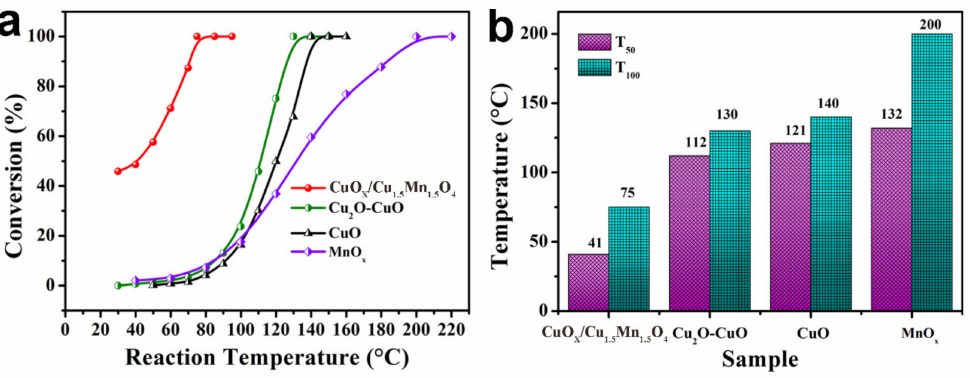
Figure 3. ( a , b ) The CO conversion performances on various